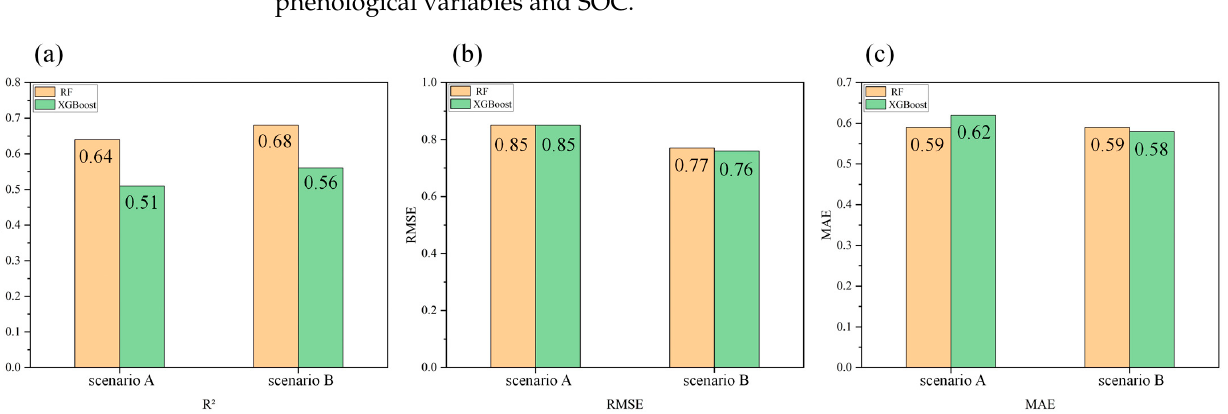
Figure 5. The histogram of model accuracy of R 2 ( a ), RMSE ( b ), and MAE ( c ), when different environmental variables were used.